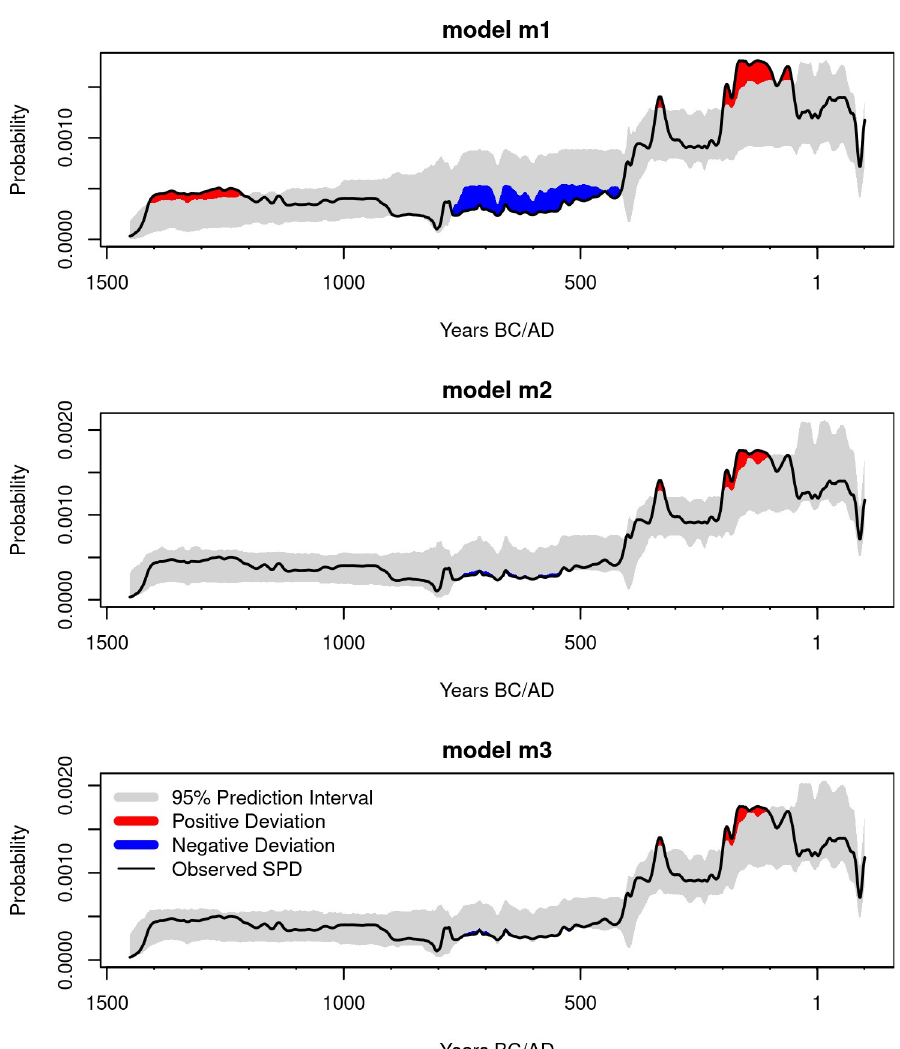
Fig 9. Posterior predictive checks. The 95% simulation interval of each model were obtained from SPDs using 500 parameter combinations from the posterior samples. Samples were generated using the calsample algorithm in rcarbon